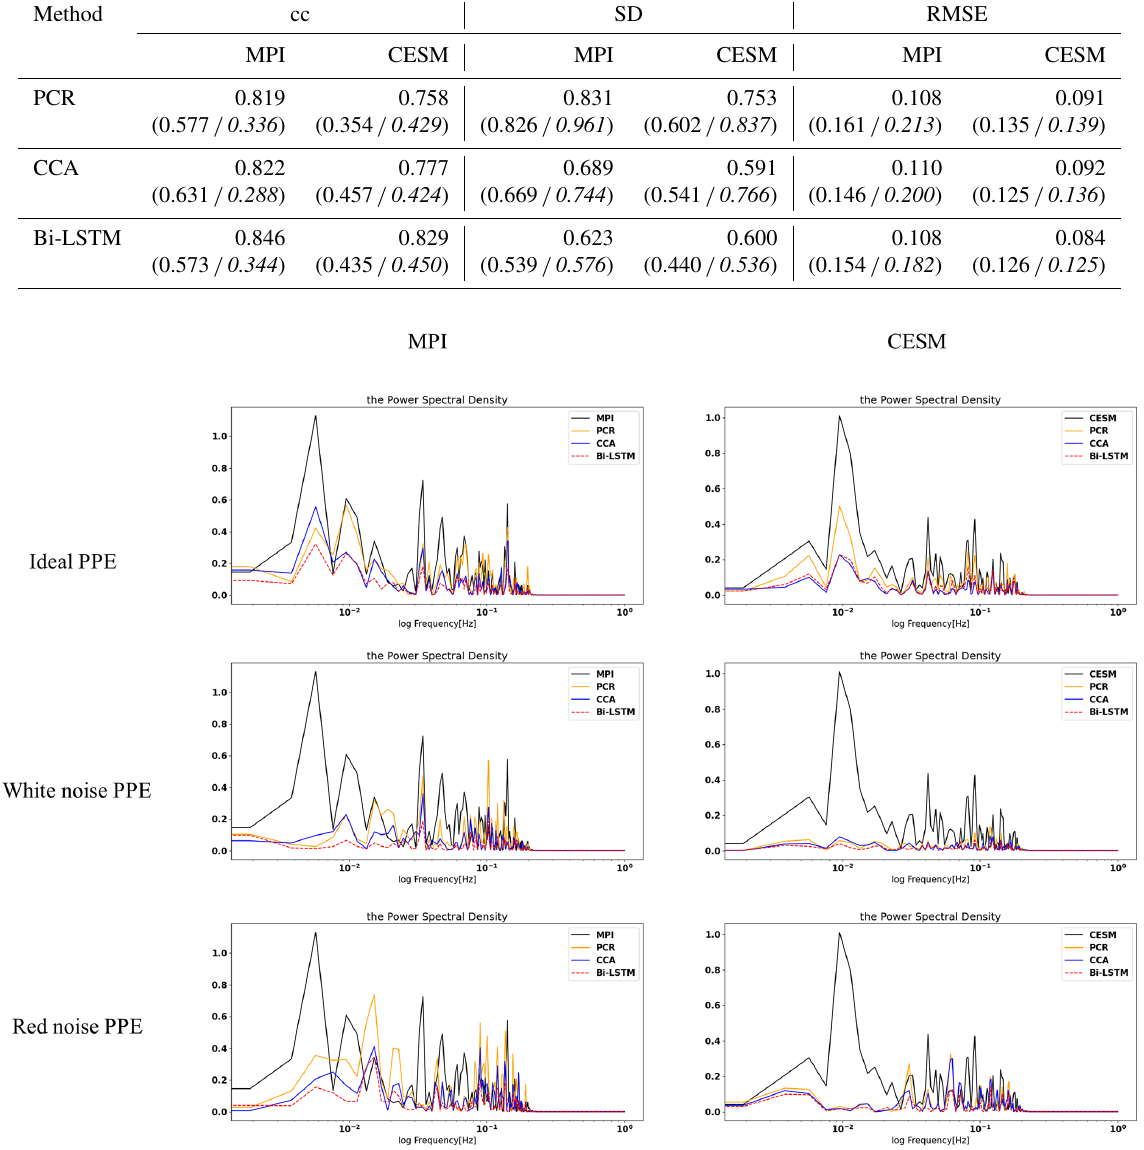
Figure 13. Power spectral densities of Northern Hemisphere